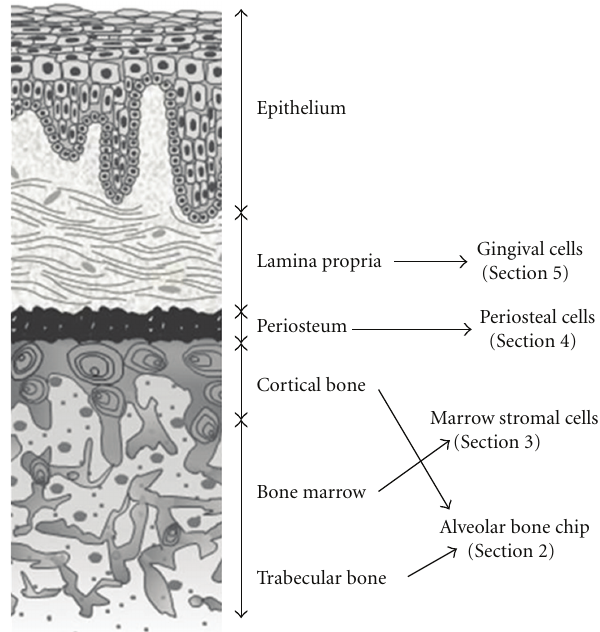
Figure 1: Sectional scheme of edentulous alveolar ridge. Figure shows the origin of candidate tissues and the cells we could harvest from alveolar bone chip, bone marrow, periosteum, and